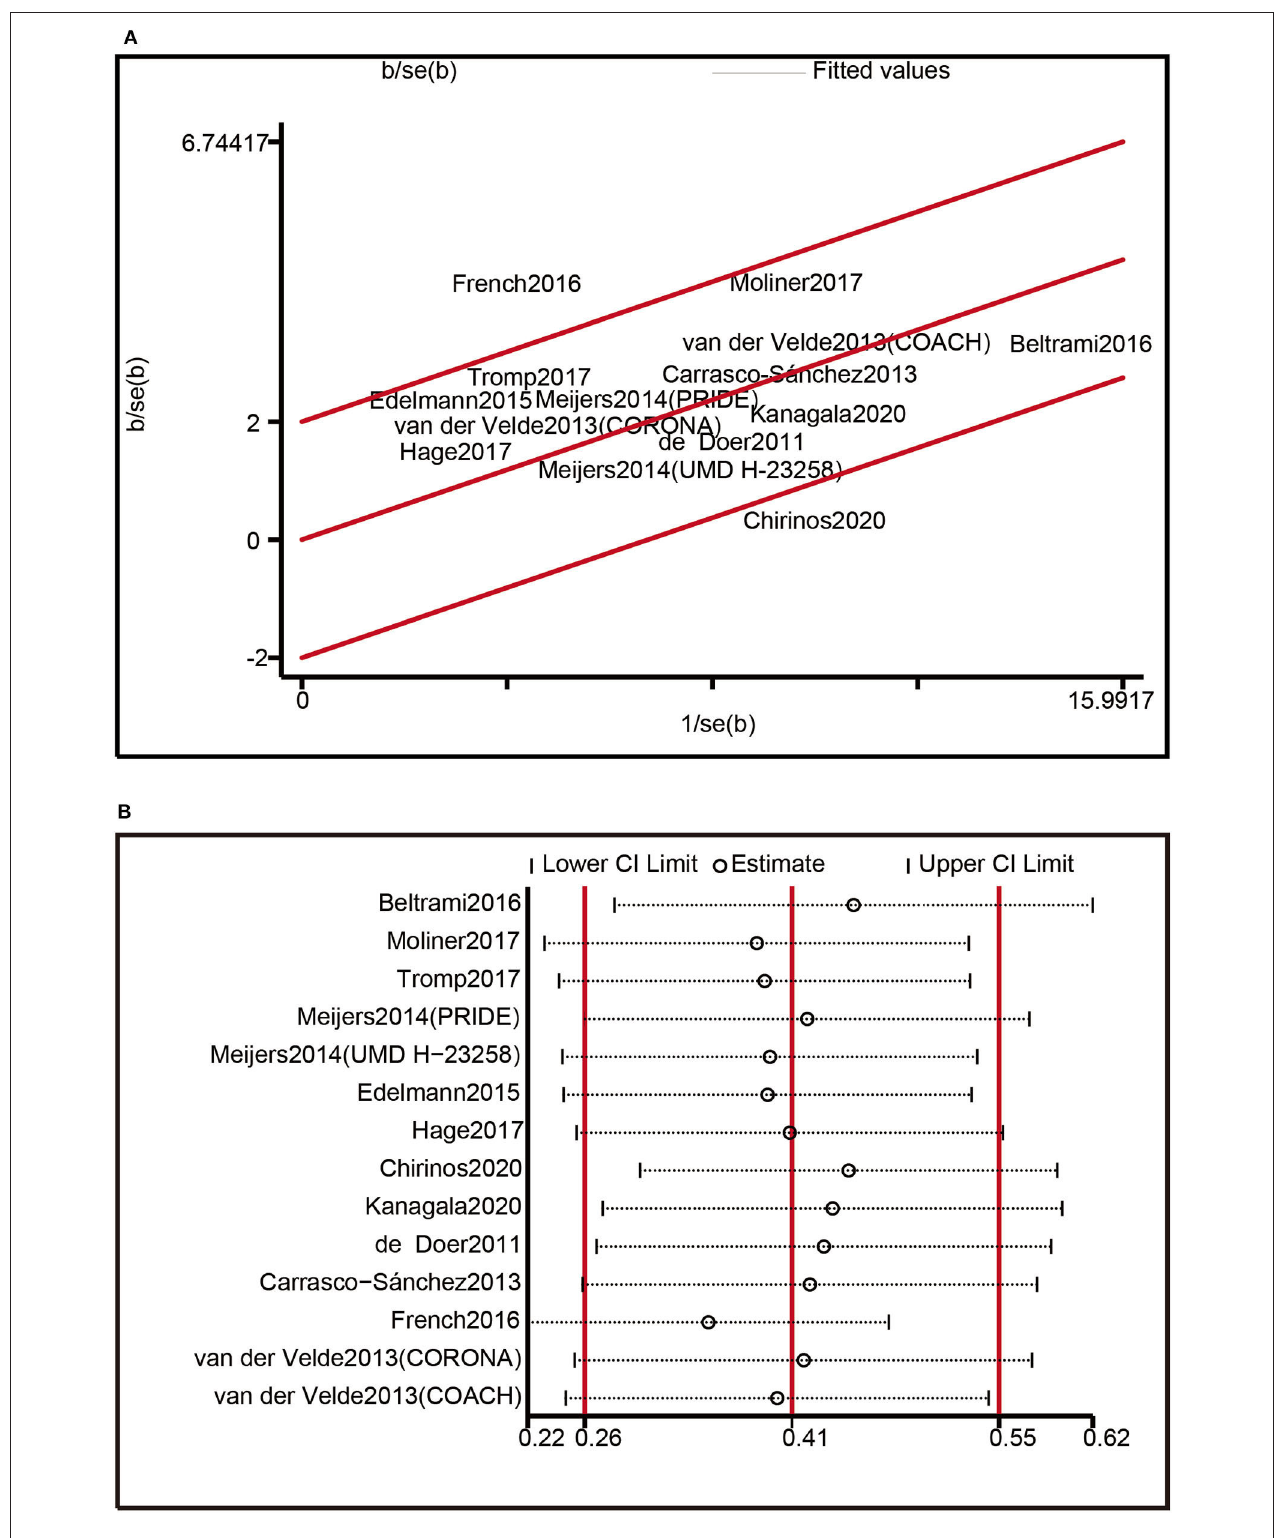
FIGURE 5 | Heterogeneity analysis: (A) Heterogeneity was evaluated by Galbraith radial plot. (B) Sensitivity analysis.